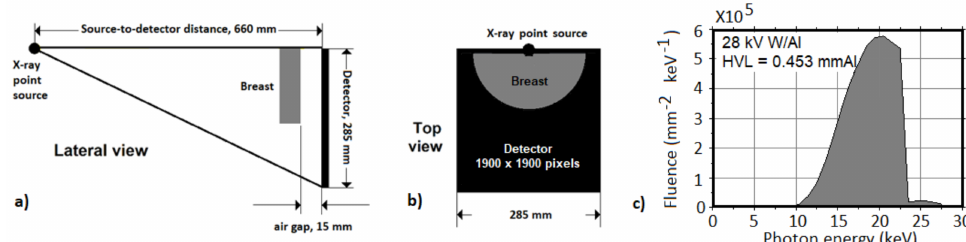
Figure 1. Scratch of the lateral view ( a ) and the top view ( b ) of the simulated setup for the flat field and uniform cylinder test. The X-ray source was at 595 mm (SOD) from the object and at 660 mm (SDD) from the 285 × 285 mm 2 (1900 × 1900 pixel) detector. In ( c ) is shown the 28 kV W/Al X-ray spectrum used in these